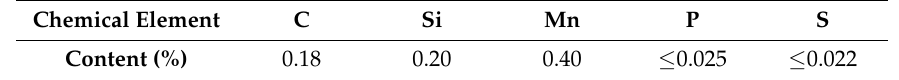
Table 1. Chemical composition and content of Q235.